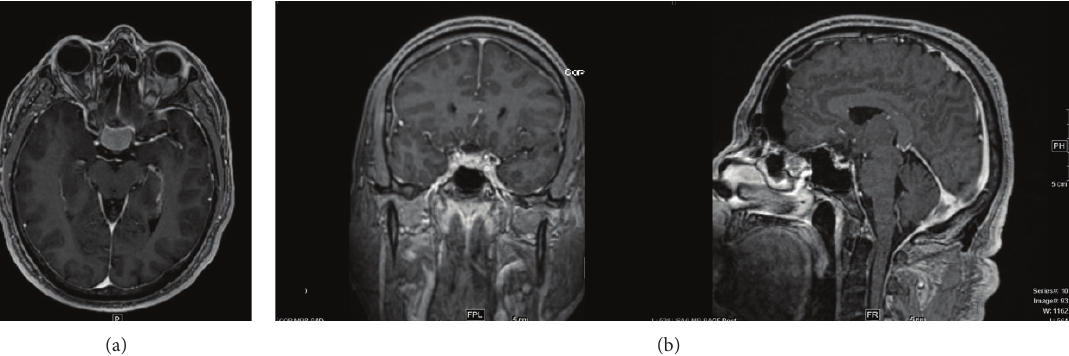
Figure2:(a)Preoperativeand(b)postoperativeMRimagesofahomogenouslyenhancingmassinvolvingtheplanumsphenoidale.Pathology was meningioma. Gross total resection was